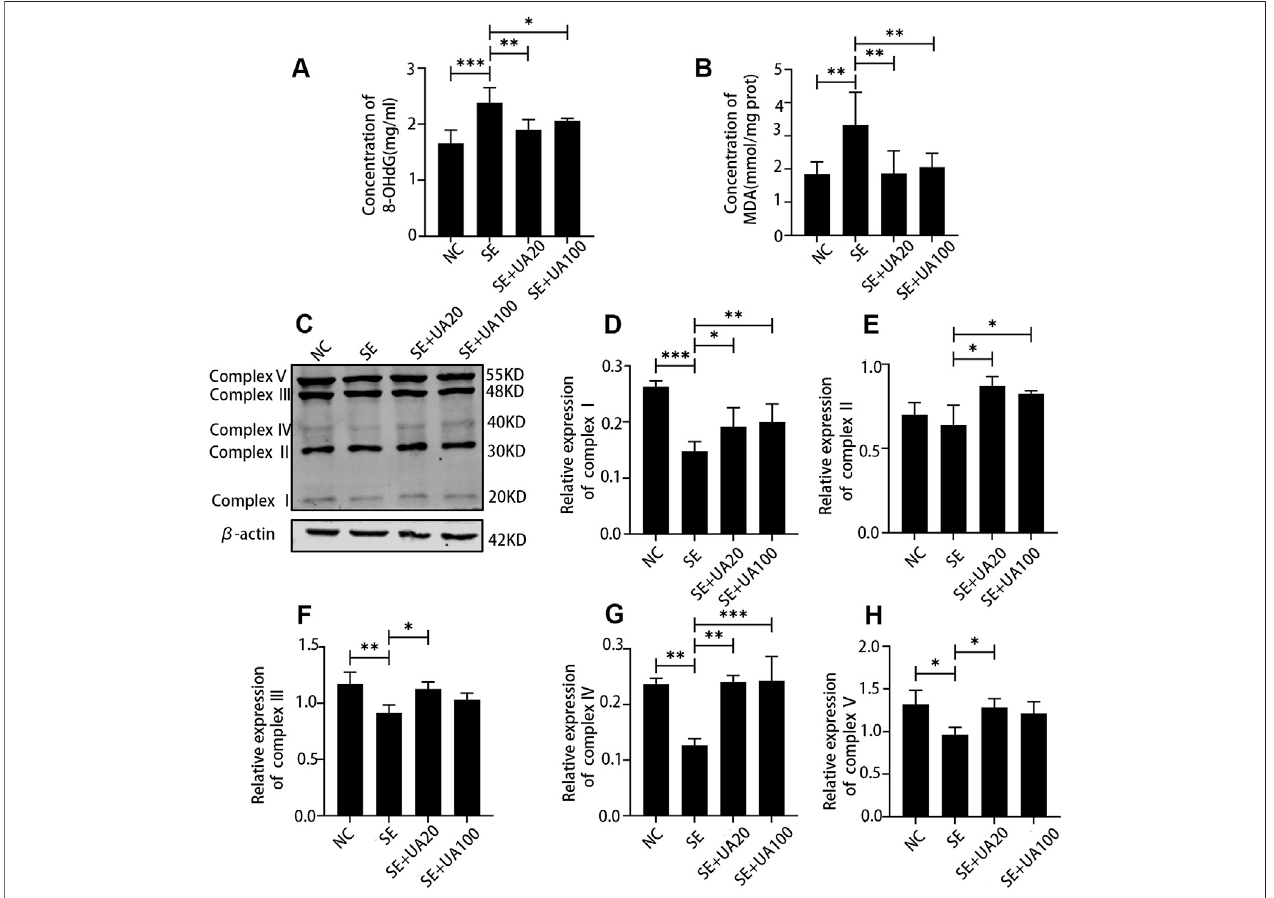
FIGURE7| UAreducedoxidativestressandimprovedthemitochondrialfunctioninducedbySEinthehippocampus.Theexpressionof8-OHdG (A) andMDA (B) , n = 6. (C) Western blot assay of oxidative phosphorylation (OXPHOS) enzyme complexes of mitochondria. (D – H) Relative density analysis of the OXPHOS enzyme complexes I – V of mitochondria. β -Actin was probed as an internal control, n = 3. ( ppp p < 0.001, pp p < 0.01, p p < 0.05 vs . SE, all values were expressed as means ±SD, one-way ANOVA).